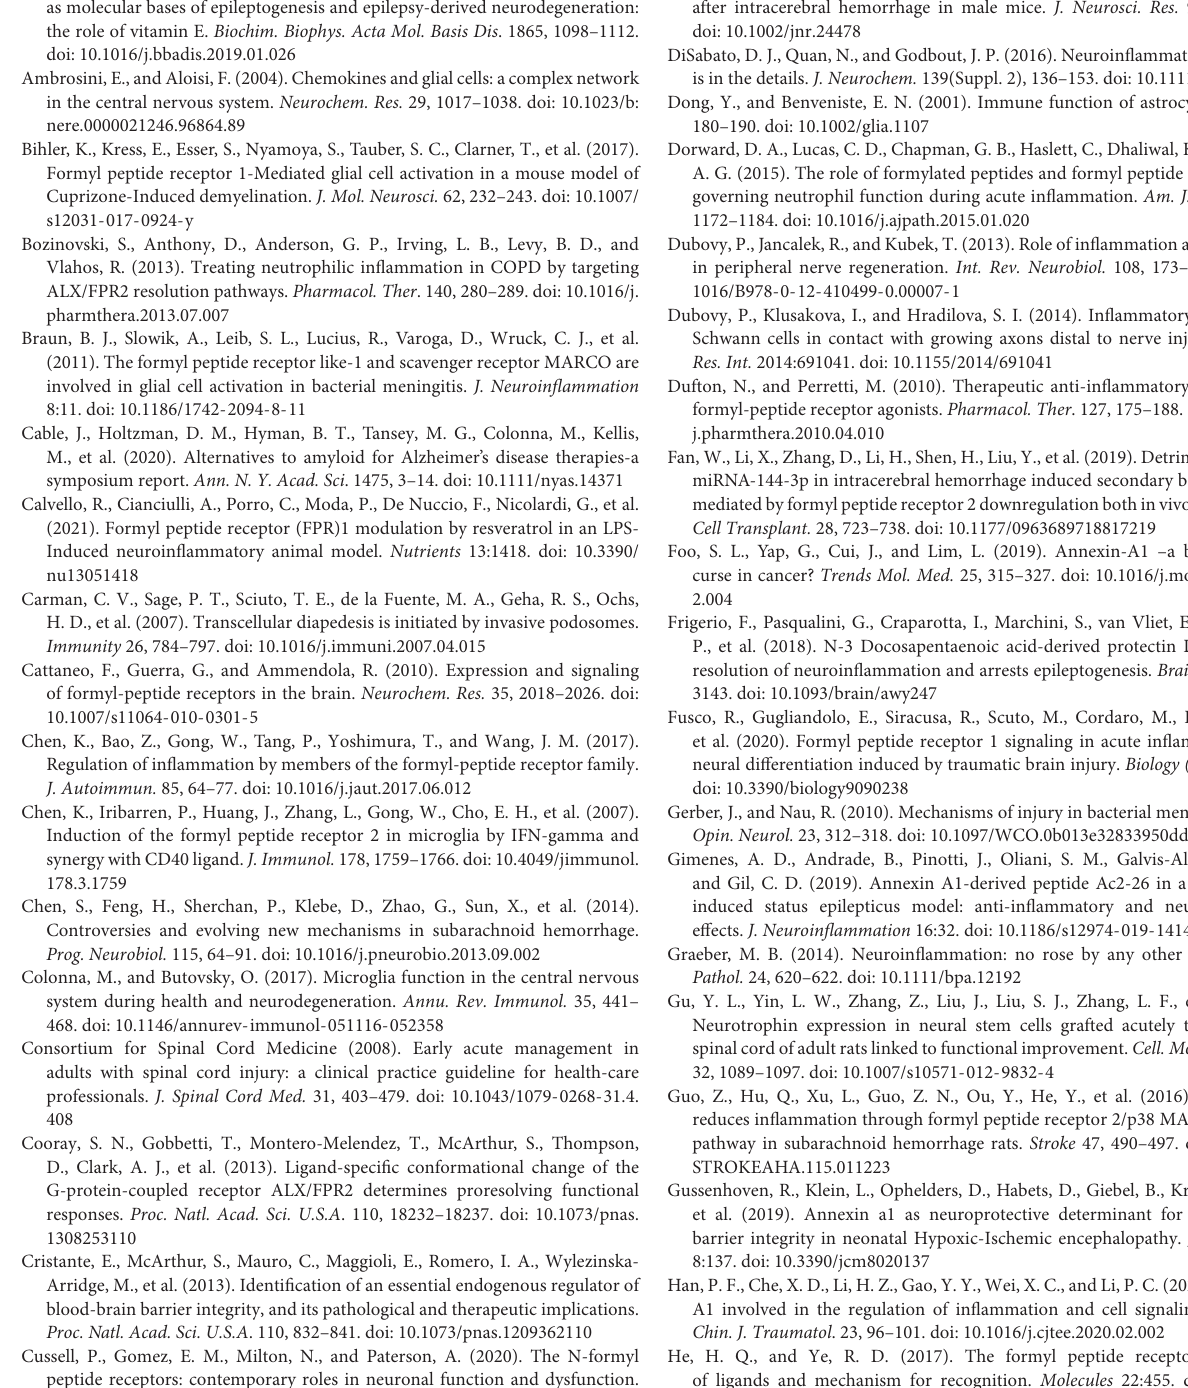
He, H. Q., and Ye, R. D. (2017). The formyl peptide receptors: diversity of ligands and mechanism for recognition. Molecules 22:455. doi: